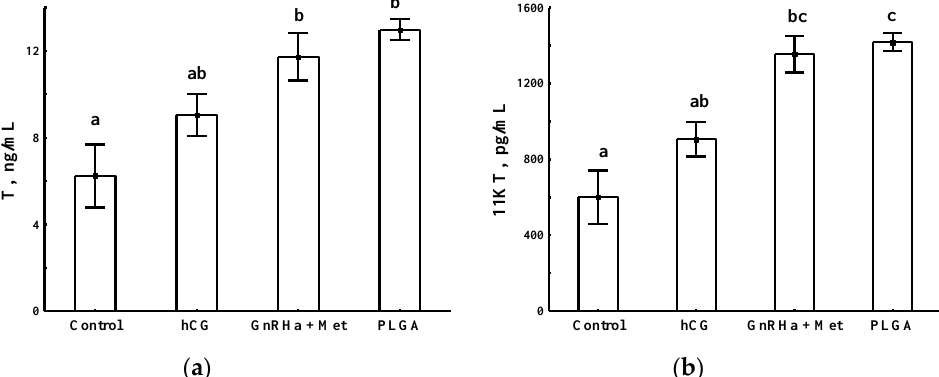
Figure 2. ( a ) Plasma testosterone (T) concentrations in bala sharks after hormone treatment; ( b ) plasma 11-ketotestosterone (11-KT) concentration after hormone treatment in bala sharks. Control (1 mL/kg 0.9% NaCl); hCG (20 μg/kg recombinant hCG); GnRHa + Met (25 μg/kg [D -Ala 6 , Pro 9 , NEt]-GnRH with 20 mg/kg metoclopramide); PLGA (PLGA microparticles). Different letters indicate significant differences ( p < 0.05; Kruskal – Wallis test, multiple comparisons of mean ranks for all groups). Data are expressed as the mean ± SE.